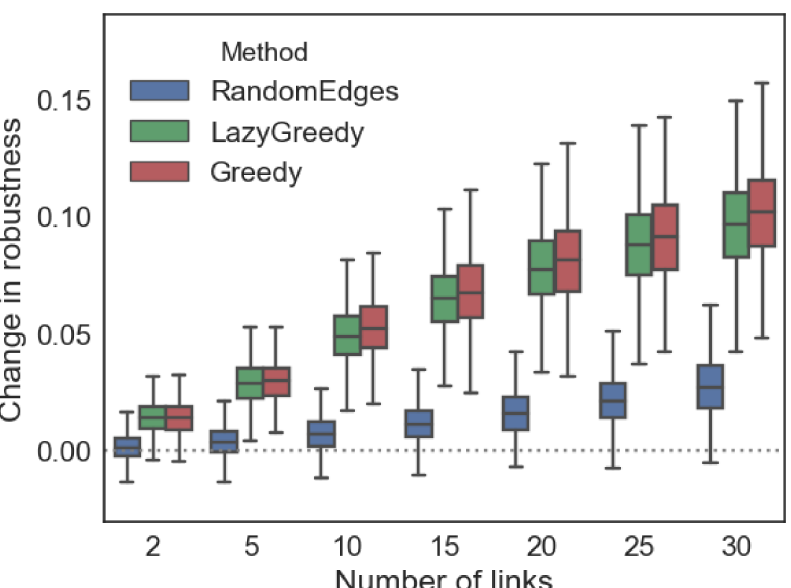
Fig 7. The robustness of networks increases with the number of additional links added using the Greedy or Lazy Greedy algorithm. The horizontal axis shows the number of links added to the network, the vertical axis the change in robustness. Colours indicate the algorithm used and each box shows the results over all landscape-based habitat networks.